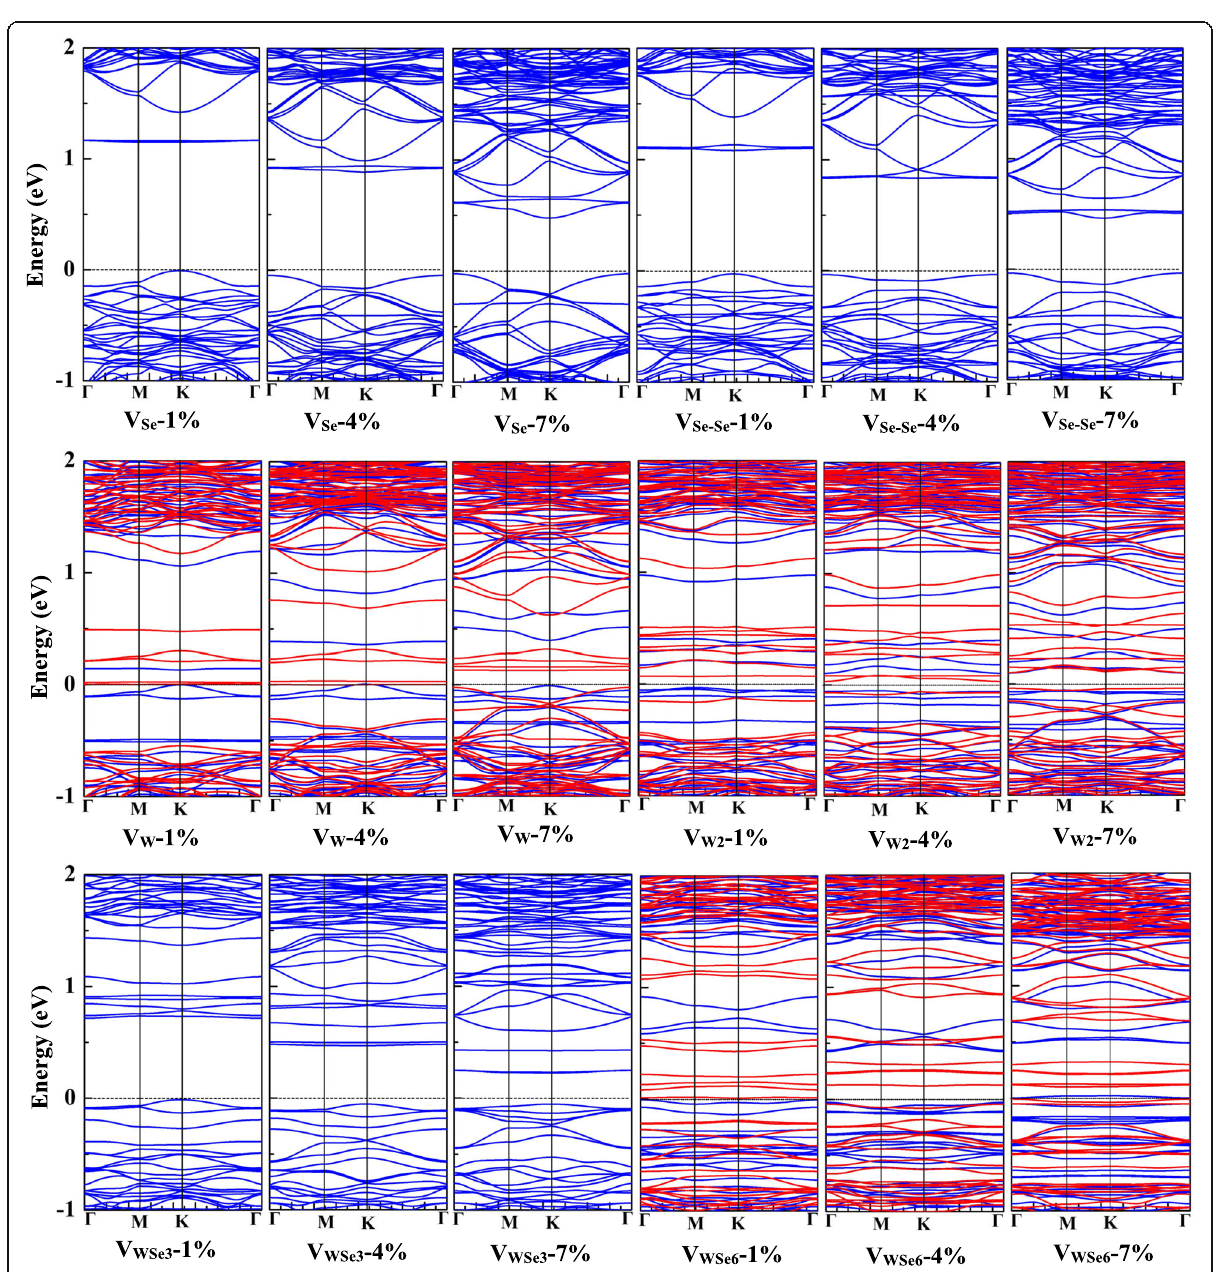
Fig. 5 The electronic band structures of monolayer WSe 2 with V Se , V Se-Se , V W , V W2 , V WSe3 , and V WSe6 vacancies under 1%, 4%, and 7% tensile strain. Blue and red lines represent the majority and minority spin channels, respectively. Fermi level is set as 0